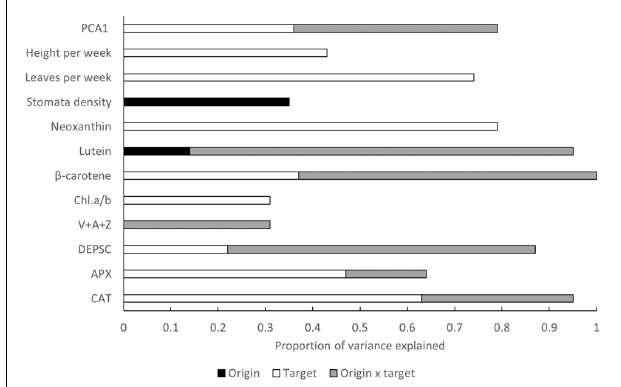
FIGURE 4 | Proportion of variance explained by plant origin expressed as altitudinal category, target (growth chamber) and origin × target out of the variance explained by the whole model. PCA1 represents the composite trait summarizing all the measured response